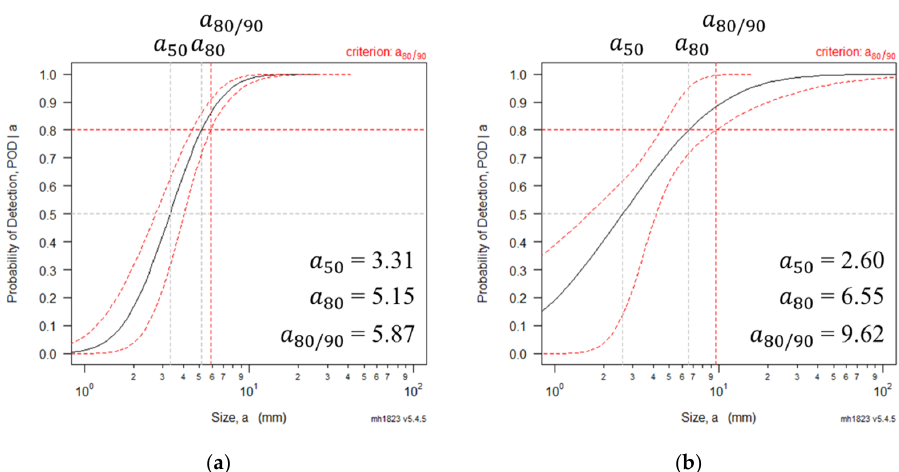
Figure 3. POD analysis results obtained by classifying planar and volumetric flaws: ( a ) planar flaws; ( b ) volumetric flaws.